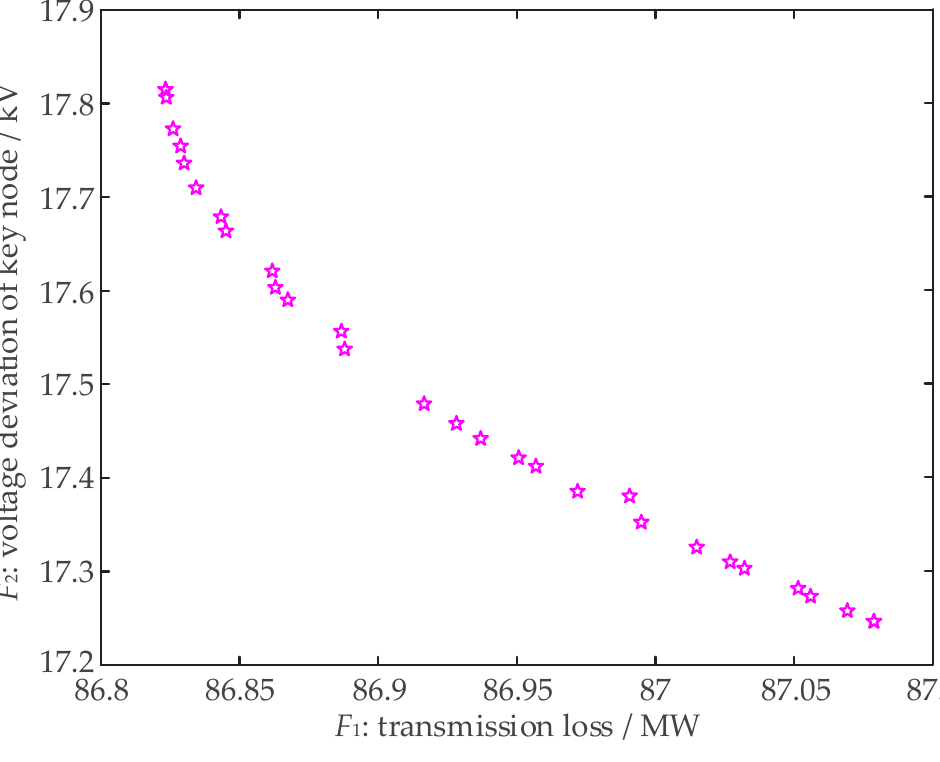
Figure 10. Result of multi-objective genetic algorithm. According to Formulas (20) and (21), the maximum satisfaction method is used to obtain the optimal compromise value of the DC current. The optimal compromise command value of the DC current flowing through the high-voltage converter and the low-voltage converter is 3.12 kA and 4.38 kA, respectively. A total of 15 groups of typical data were taken for comparison, as shown in Table 1. U 1 ’and U 2 ’ represent the DC voltage of the low-voltage line and high-voltage line at the inverter side, respectively. With the increase in the DC current of the low-voltage line, the power loss decreases. When I d1 increases, the DC voltage of the high-voltage line at the inverter side increases. Compared with the traditional control method (No. 6 in Table 1), the proposed control method (No. 13 in Table 1) can reduce the transmission loss by 7.67% and the voltage deviation drops by